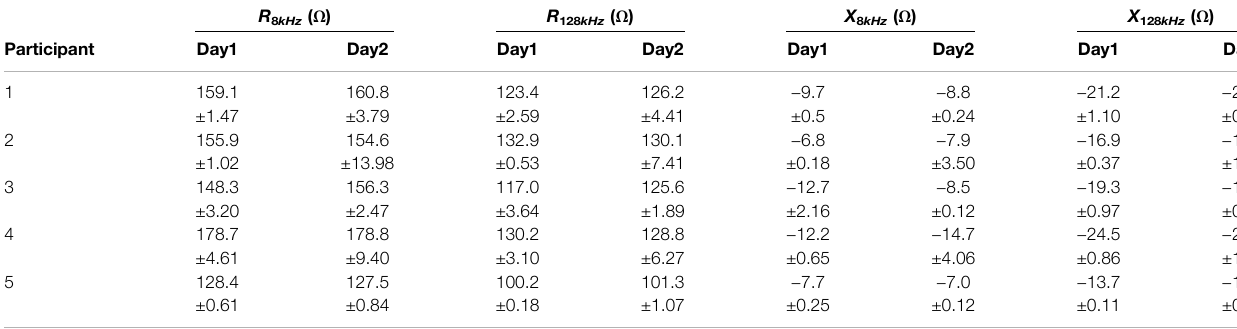
TABLE 4 | Average 8 and 128 kHz resistance/reactance from longitudinal electrodes generated using fi rst 20 artifact-free measurements.